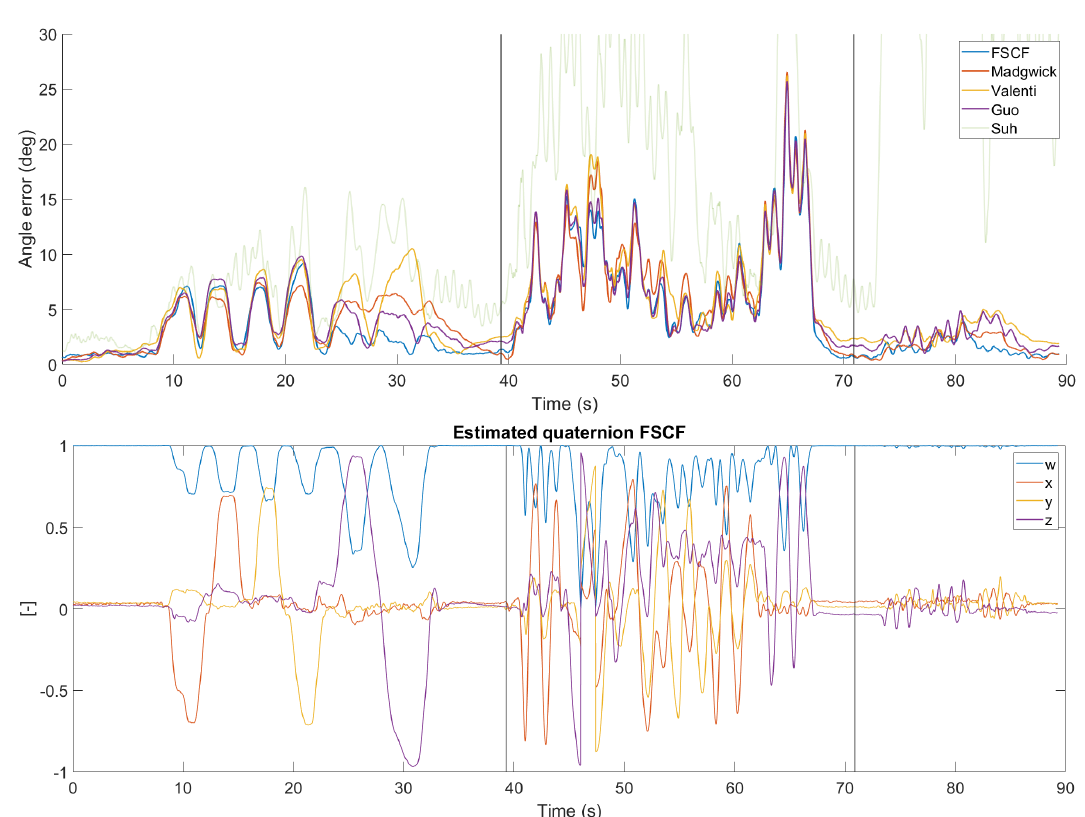
Figure 9. Error of all tested filters for the data from the third scenario ( top row ): slow rotations ( left ), fast rotations (middle), and dynamic acceleration ( right ). Parameters of all filters were tuned for the best overall performance. Quaternion estimated by the fast separated correction filter (FSCF) is displayed for illustration ( bottom row